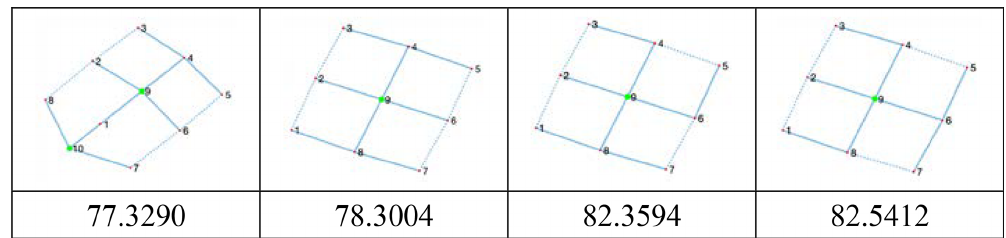
Figure A3. A total of four displacement graphs of 8bar 3 DOF planetary gear